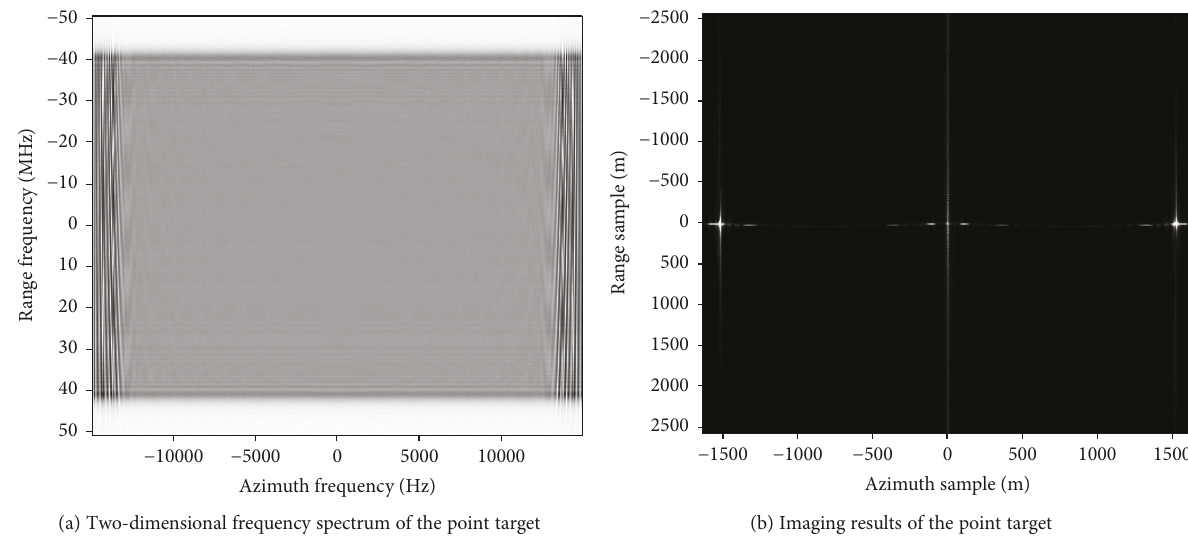
Figure 4: Imaging results by the traditional method in literature [10].